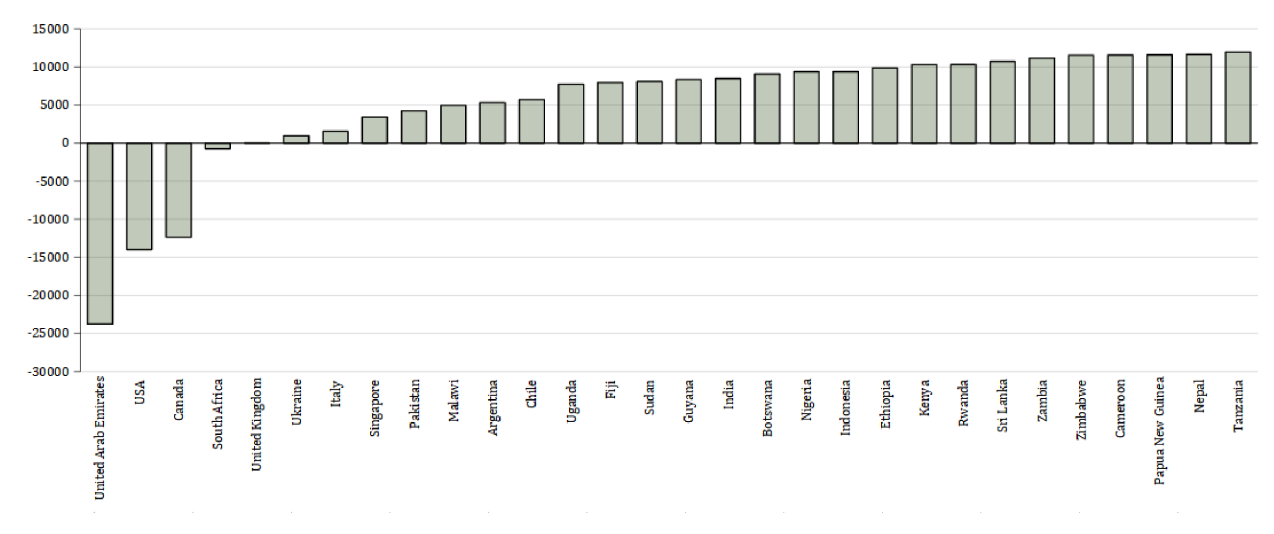
Figure 2. Difference in net emissions (kg CO ) between physical attendance in Manchester and studying online at home. X axis 2 shows the country from which the students come. Y axis shows the net difference in emissions between the UK and each country in kg CO 2